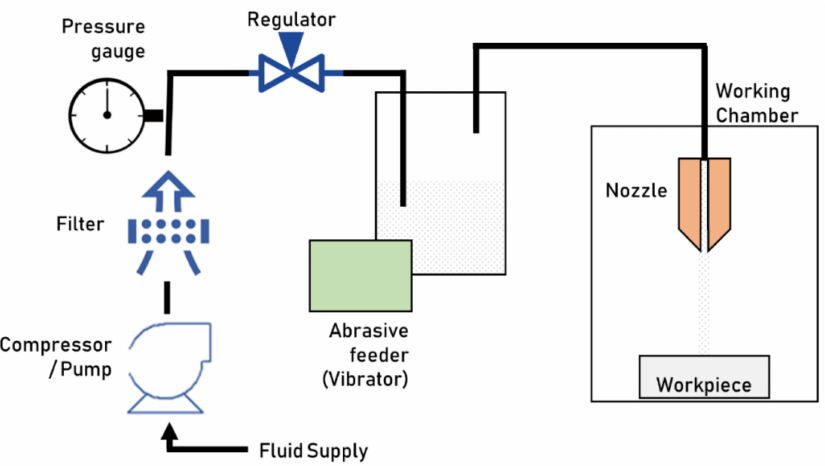
Figure 3. Schematics of the abrasive jet machining